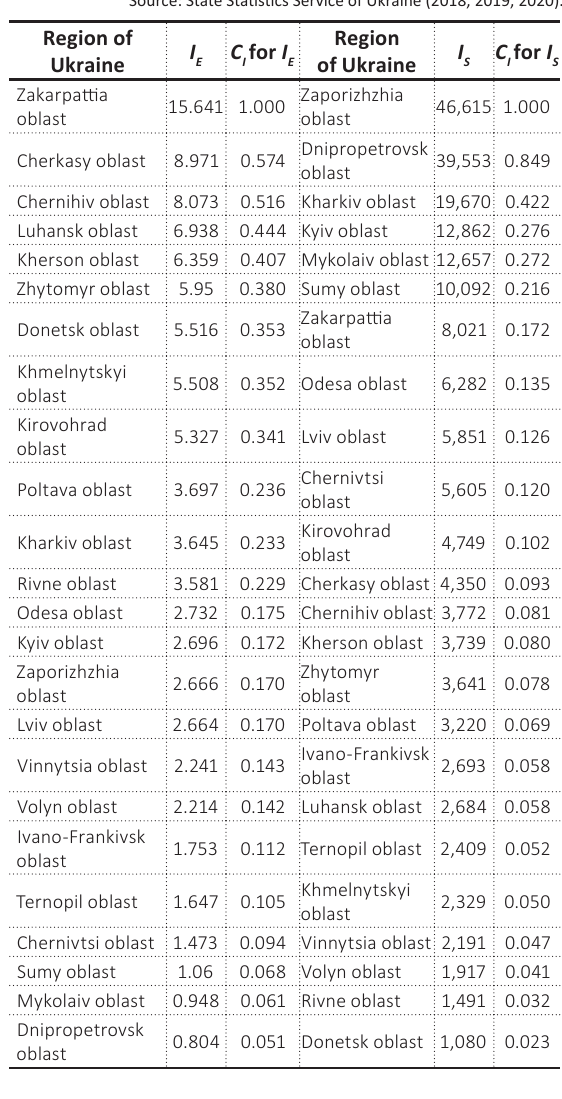
Table 6. Average values of indicators I and for them, the values of indicators C by regions of Ukraine, 2017–2019